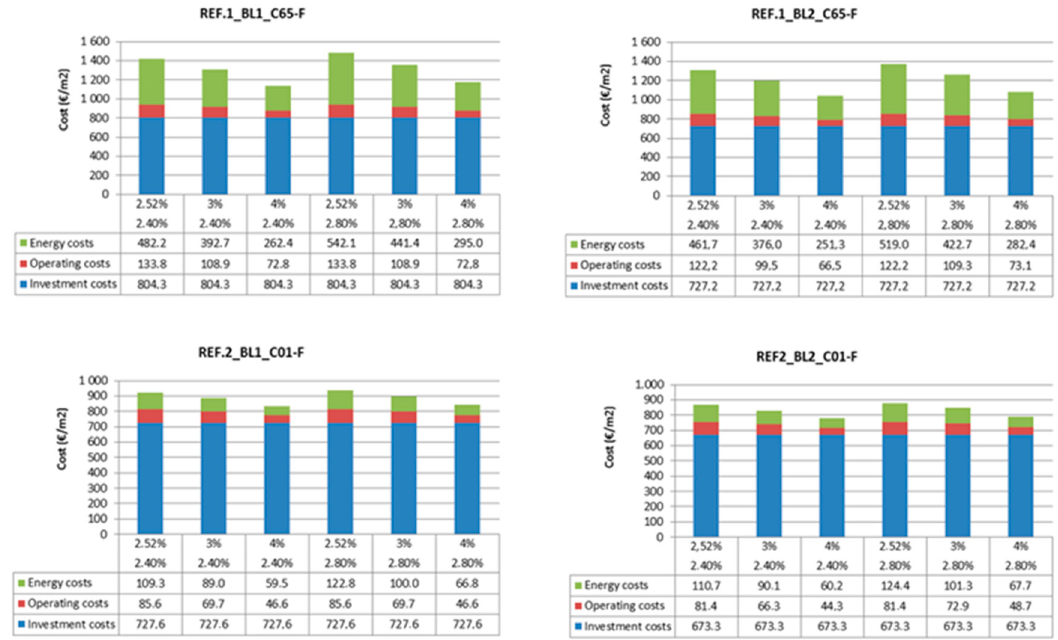
Figure 5. Sensitivity analysis for Reference building 1.